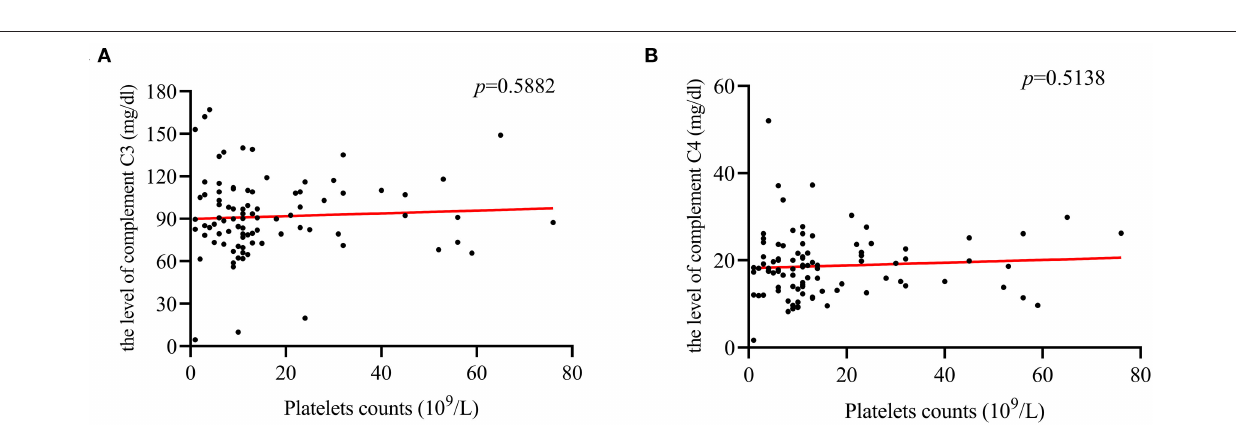
Frontiers in Pediatrics |